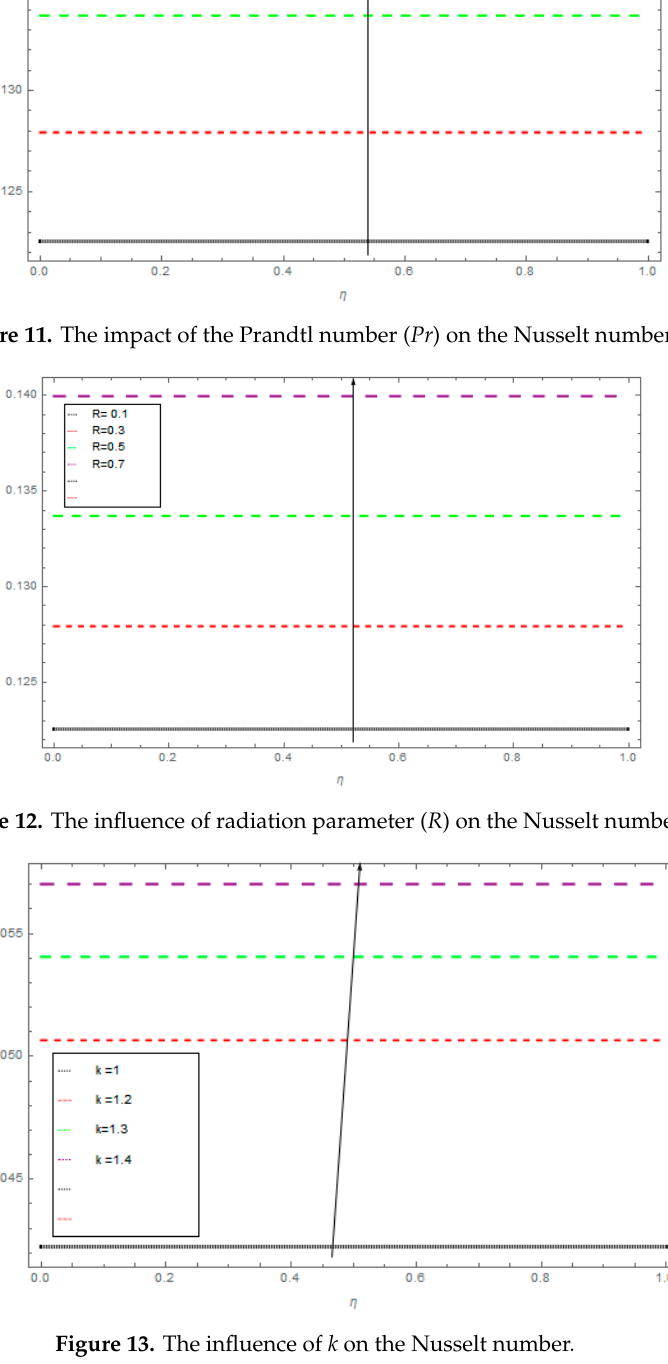
Figure 13. The influence of k on the Nusselt number.